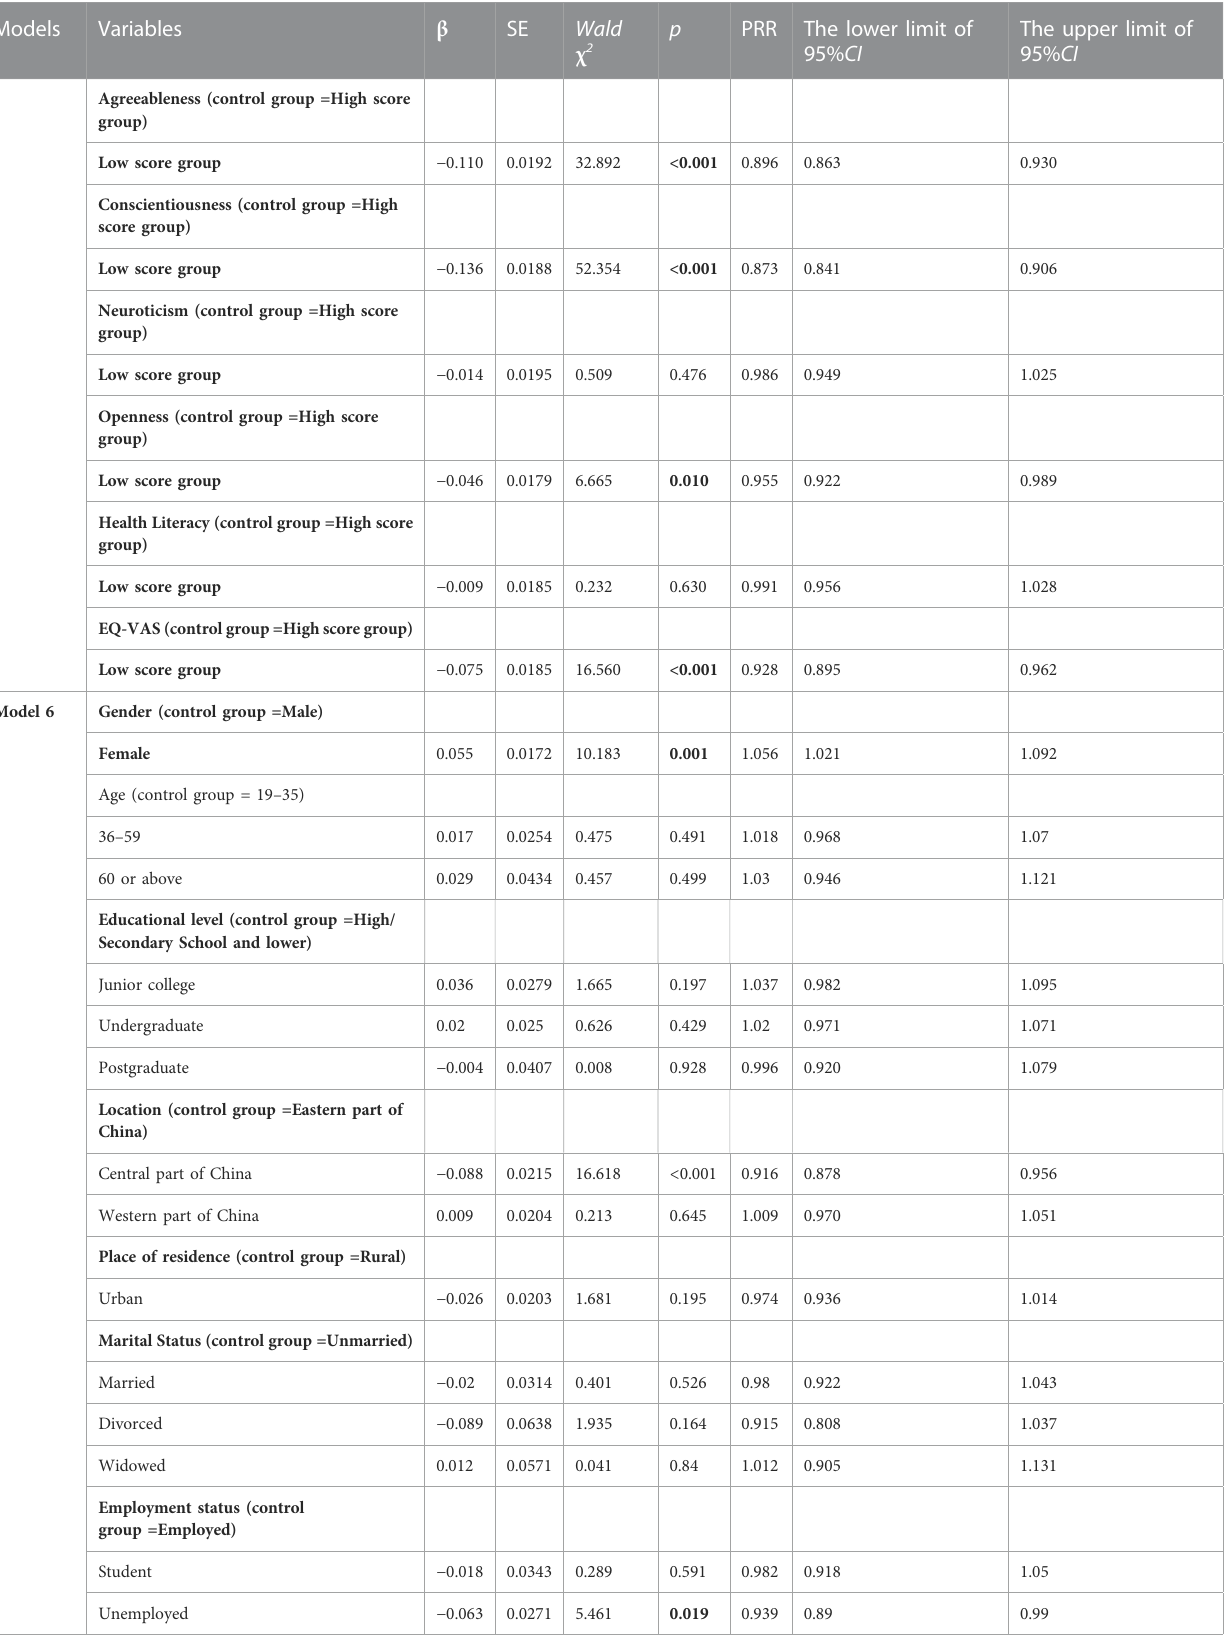
TABLE 4 ( Continued ) Multilevel log-binomial regression results with drug ef fi cacy as the dependent variable.